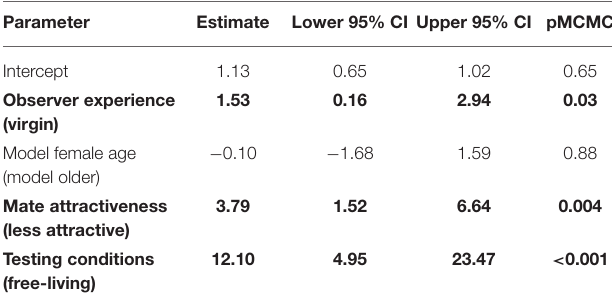
TABLE 1 | Heterogeneity explained by random effects in competing meta-analytic models. Meta- analytic